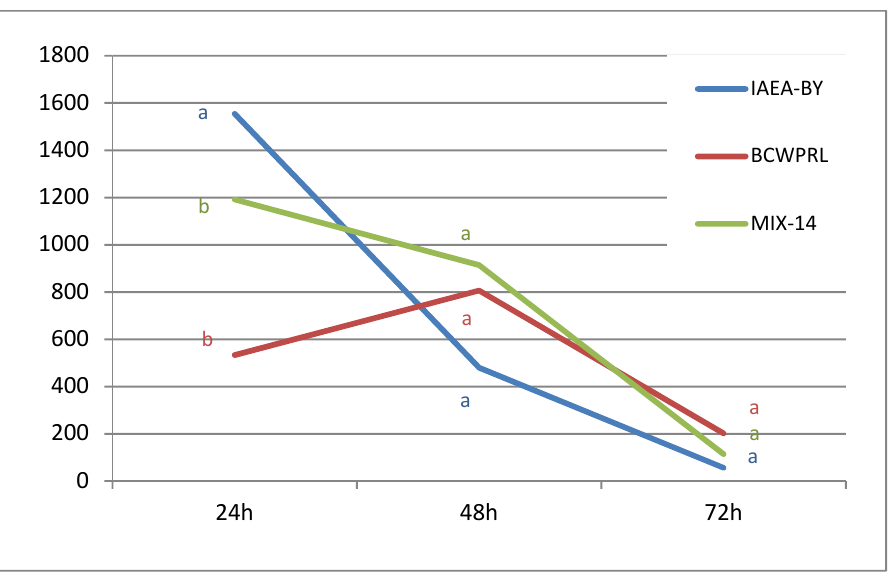
Figure 2. The mean number of male pupae collected 24 h, 48 h, and 72 h after the pupation onset (reared from 4000 eggs using three different larval diets). Values followed by the same letter are not significantly different (Tukey HSD test; α = 0.05).